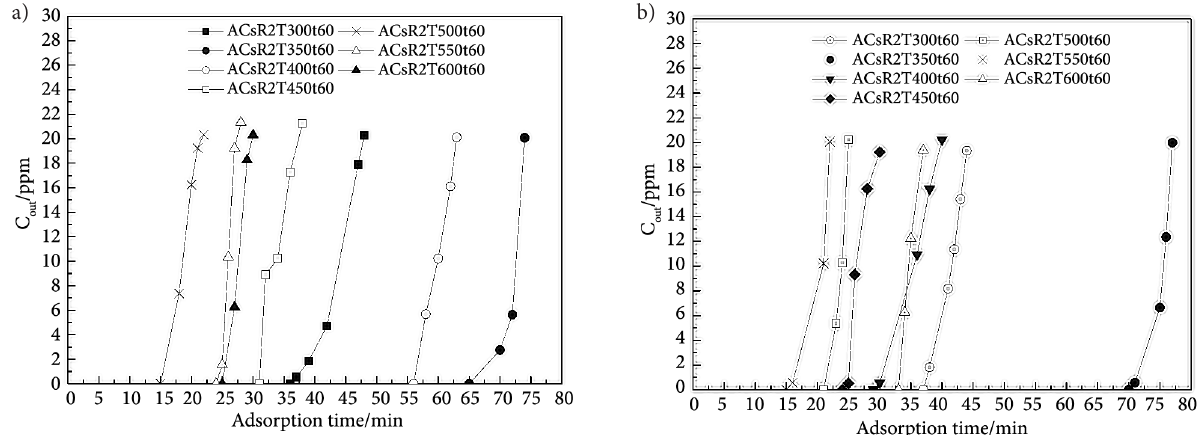
Figure 2. Adsorption time curves for stalk carbon prepared using different activation temperatures (a: ACs; b: